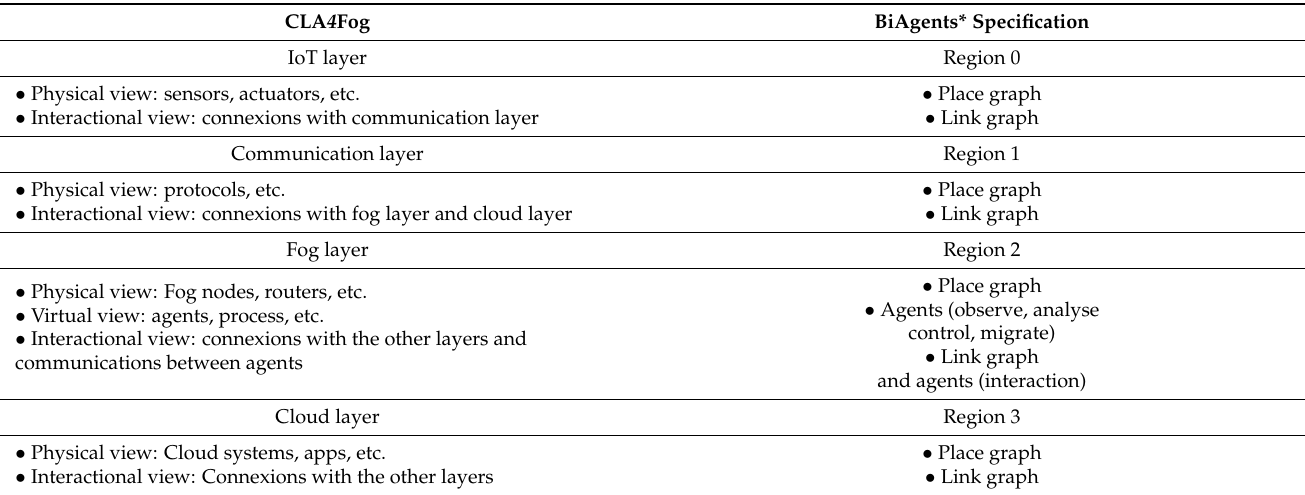
Table 2. CLA 4 Fog and BiAgents*